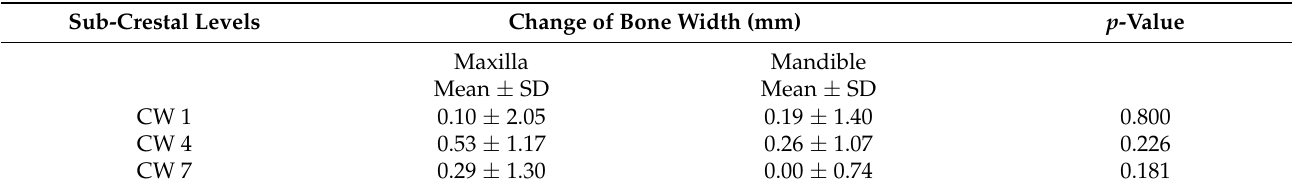
Table 3. The differences in the change of bone width around implants at three levels were found between maxilla and mandible.